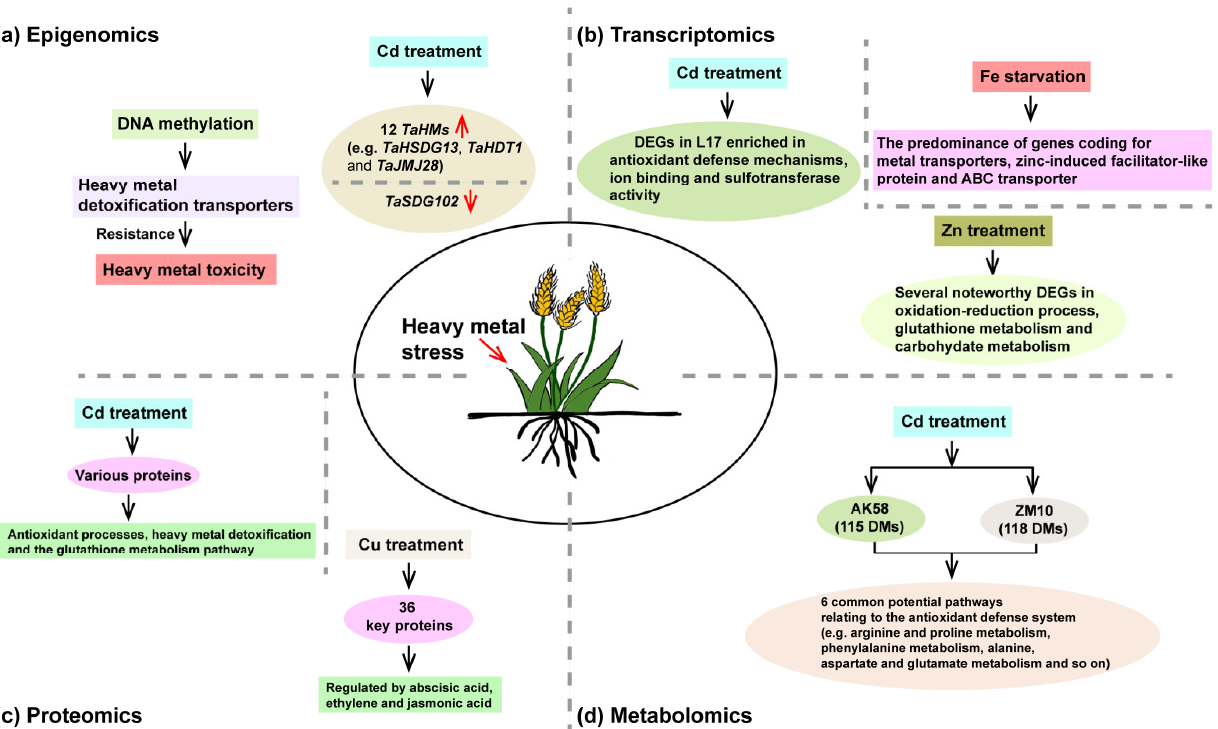
Figure 1. Multi-omics reveal the mechanism of wheat under heavy metal stress. Epigenomics ( a ), transcriptomics ( b ), proteomics ( c ) and metabolomics ( d ) reveal heavy metal stress in wheat. DEGs, differentially expressed genes. DMs, differential metabolites. Up red arrow means upregulated, down red arrow means downregulated.